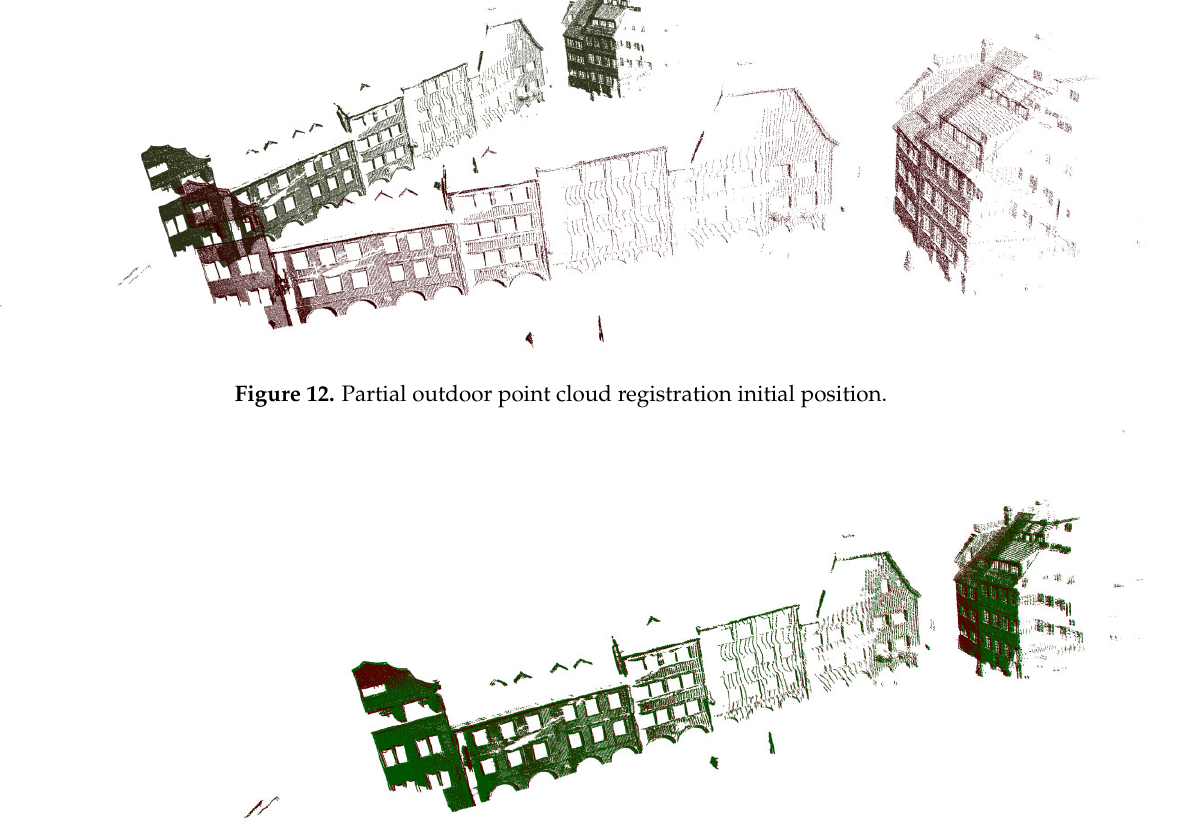
Figure 13. Optimal registration effect of some outdoor point clouds.